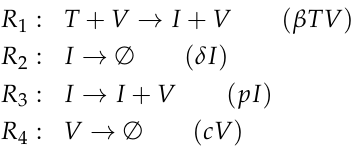
Figure A1. Reactions of Baccam model